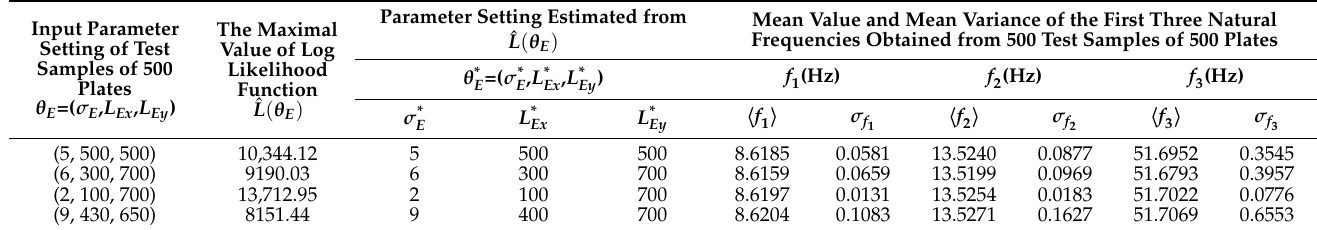
Table 1. The maximum likelihood estimation of test samples when considering random field E .